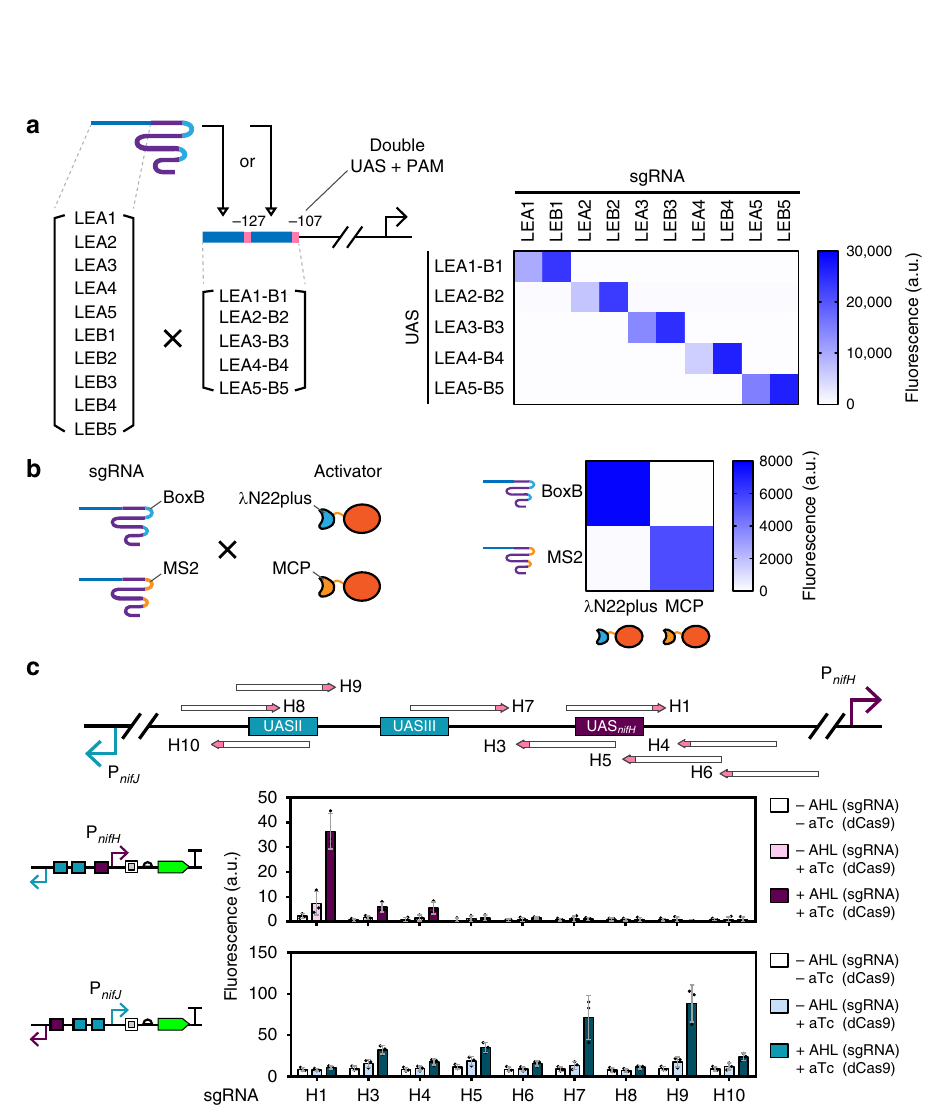
Fig. 4 Orthogonality tests of the CRISPRa system. a Orthogonality owing to UAS-sgRNA speci fi city. The spacer length for LEA site is 20 bp, and the spacer length for LEB site is 17 bp. Activator expression was driven by the constitutive promoter BBa_J23106. Inducer concentrations used: 1.6 µ M AHL (sgRNA), 2.5 ng mL − 1 aTc (dCas9). b Orthogonality between different RNA aptamer-adaptor pairs. Activators expressions were driven by the promoter BBa_J23106. Inducer concentrations used: 0.08 m M arabinose (sgRNA), 2.5 ng mL − 1 aTc (dCas9). c Orthogonal UAS for P nifH and P nifJ . Nine selected UAS between the two promoters were tested in activating P nifH and P nifJ , respectively (bottom left). Inducer concentrations used: 1.6 µ M AHL (sgRNA), 2.5 ng mL − 1 aTc (dCas9), 3.2 m M rhamnose (activator). Error bars, s.d. ( n = 3); a.u., arbitrary units. Source data are provided as a Source Data fi